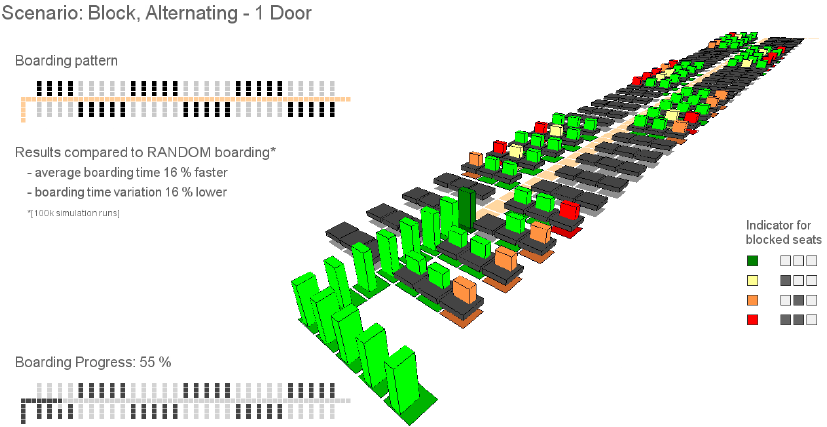
Figure 10. Visualization of the boarding process, using an alternating (half) block strategy as an example and indicating the interaction during the seating process (color coded).